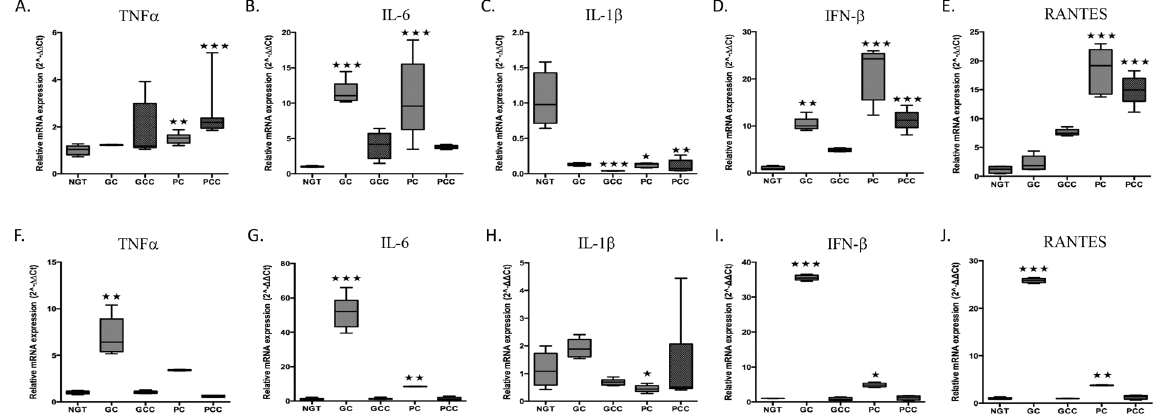
Figure 2. Gene expression of TNF α , IL-6, IL-1 β , IFN- β and Rantes in monocytes and neutrophils from NGT and T2DM patients. Analysis of TNF α ( A , F ), IL-6 ( B , G ), IL-1 β ( C , H ), IFN- β ( D , I ) and RANTES ( E , J ) gene expression in monocytes ( A – E ) and neutrophils ( F – J ) from NGT and T2DM patients (n = 8 per group). Top and bottom horizontal lines of the boxplots indicate 25th and 75 th percentiles respectively; lines within the box indicate median values. * p < 0.05, ** p < 0.01, *** p < 0.001 vs